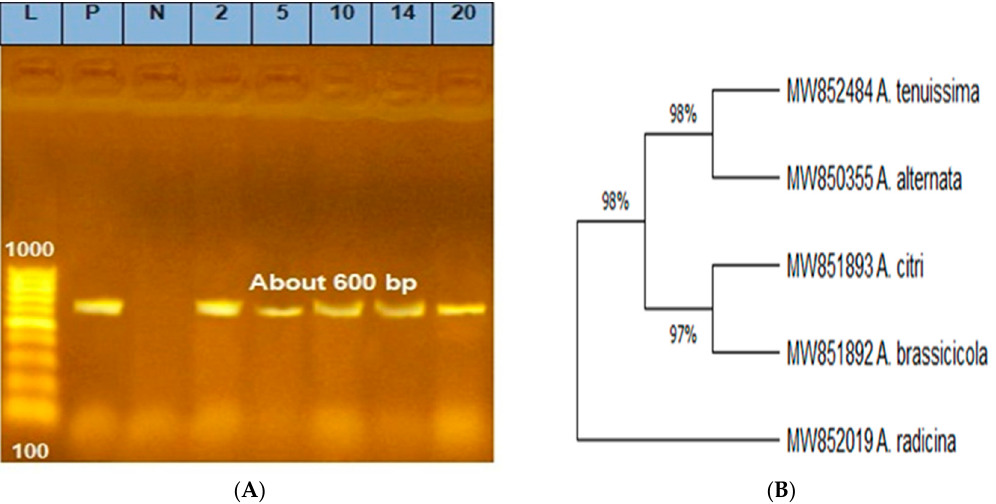
Figure 2. Agarose gel electrophoresis of PCR amplification of DNA products, PCR amplification of DNA products (~600 bp) using ITS1/ITS4 primer pair. L—ladder (100–1000 bp); P—positive control consists of a segment of DNA of known size (the same size as the target amplicon, shows that the primers have attached to the DNA strand); N—negative control: a sample without DNA, but contains all essential components of the amplification reaction show if contamination of the PCR experiment with foreign DNA has occurred; 2— A. alternata ; 5— A. citri ; 10— A. brassicicola ; 14— A. radicina ; 20— A. tenuissima ( A ) and phylogenetic tree generated from Alternaria species used in this study based on datasets of ITS rDNA gene sequences, the similarity of 97–98% among species ( B ).